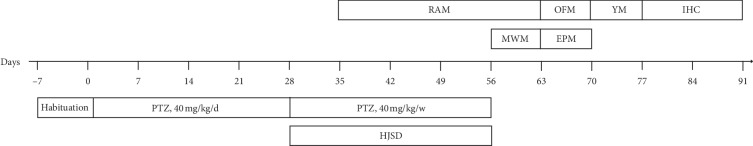
Timeline of the experiment. Habitual feeding was conducted 7 days before the formal experiment. Epilepsy was induced by intraperitoneal injection of PTZ for 28 days. The model was maintained once per week for the next 28 days. The drug administration began on day 28 and continued for 28 days. The RAM test was performed from day 35 until day 63, the MWM test was performed from day 56 until day 63, the OFM and EPM tests were conducted from day 63 until day 70, the YM test was performed from day 70 until day 77, and immunohistochemistry was performed from day 56 until day 70.